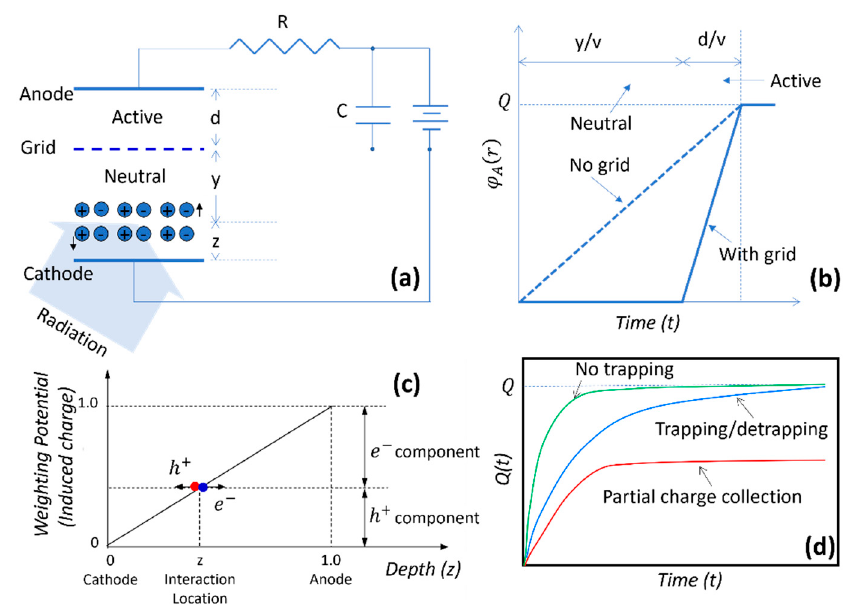
Figure 3. ( a ) The schematics of a Frisch grid detector. ( b ) The variation of weighting potential as a function of time with and without the grid for a planar detector geometry, v is the drift velocity. ( c ) The variation of weighting potential as a function of position for a planar detector geometry. ( d ) The evolution of the detector signal in the cases of charge transit without trapping, repeat trapping and detrapping, and trapping followed by recombination leading to partial charge collection.